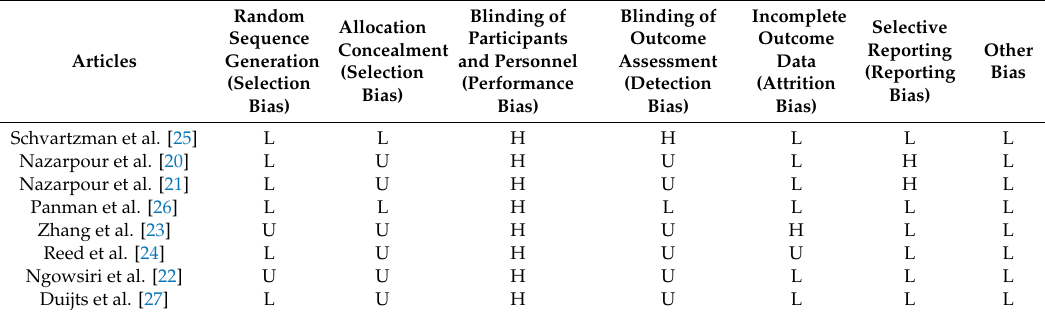
Table 1. Assessment of risk of bias for the clinical trials